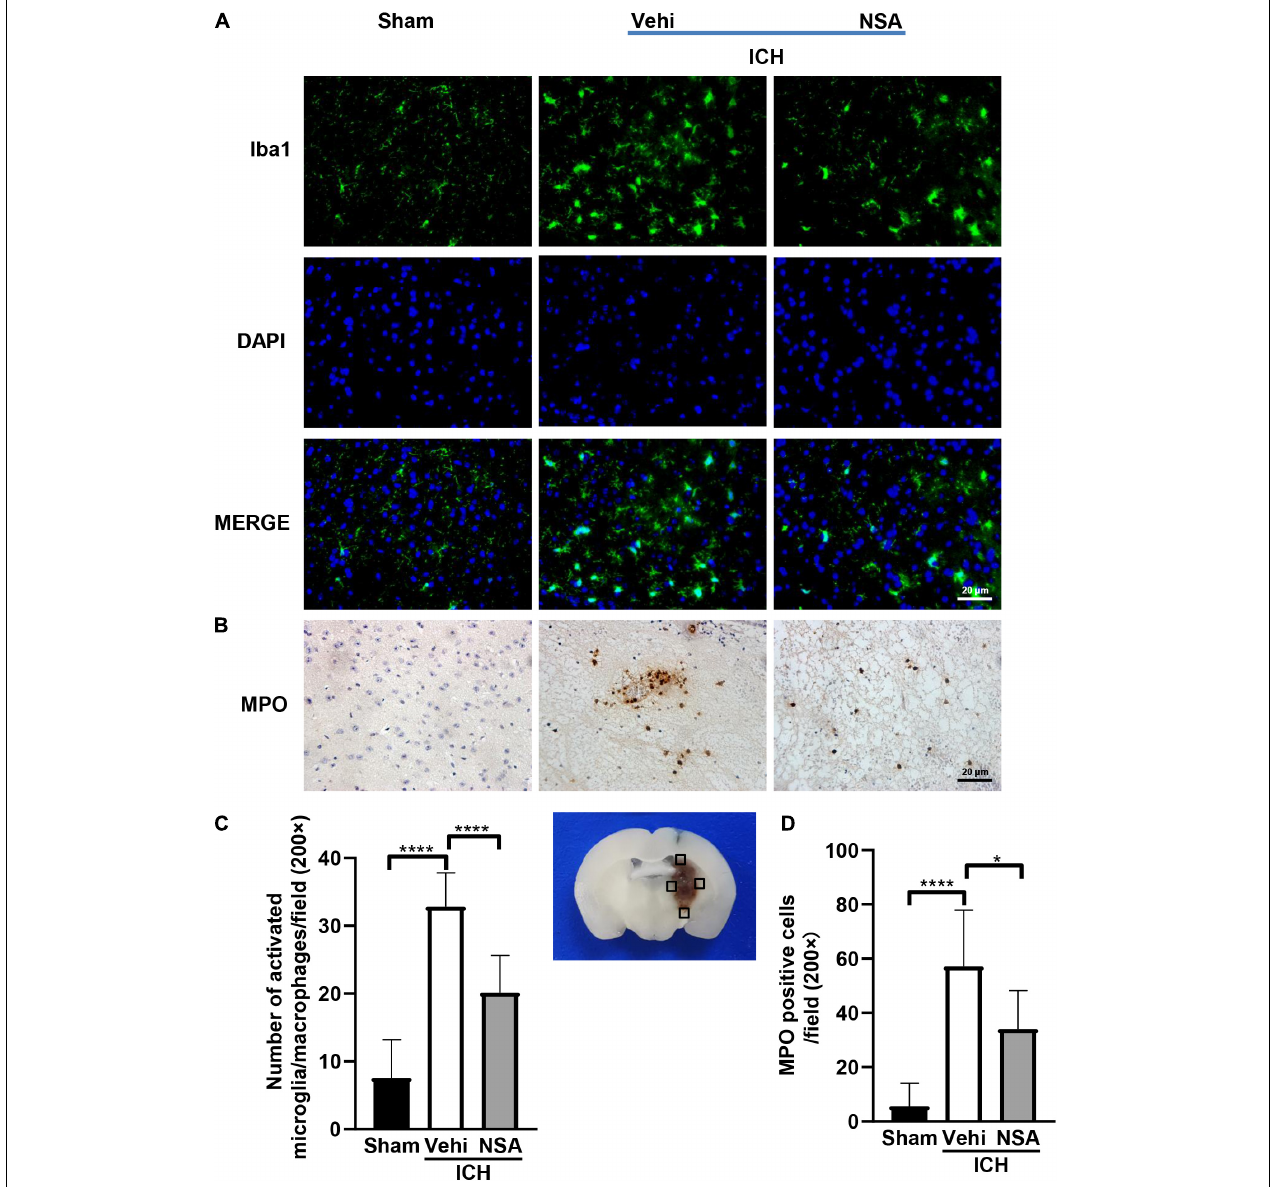
FIGURE 2 | Necrosulfonamide (NSA)repressed the activation of microglia/macrophages and neutrophil infiltration at 3 days after intracerebral hemorrhage (ICH). (A) Representative photographs of Iba1 expression in the perihematomal area at 3 days after ICH. (B) Representative photographs of immunohistochemical staining for neutrophil infiltration in the perihematomal area at 3 days after ICH. (C) Quantification shows that NSA ameliorated the activation of microglia/macrophage. (D) NSA inhibited the infiltration of neutrophils. Data are shown as mean ± SD ( n = 6, per group); scale bar = 20 µ m; * p < 0.05, **** p <